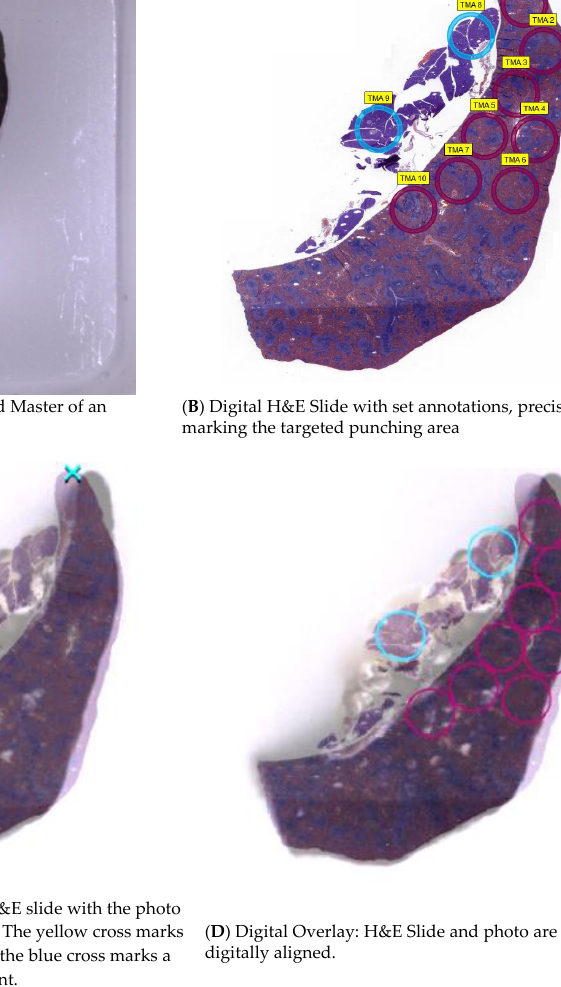
Figure 2. Digital Overlay and Alignment. Shown is the digital overlay and alignment using a photo taken by the tissue microarrayer and the digitalised H&E slide with the previously set annotations marking the targeted punching area. ( A ) picture taken by the TMA Grandmaster of an inserted donor block. The two crosses mark the uppermost und lowermost border of the tissue. ( B ) Digital H&E Slide with set annotations. It is possible to choose different colours for each target area. ( C ) Overlay of the H&E slide with the photo taken from the TMA Grandmaster and demonstrates the sometimes-occurring alignment difficulties. The yellow cross marks an area of proper alignment, and the blue cross marks a poor alignment. ( D ) Digital Overlay after alignment of the H&E Slide and photo with previously set